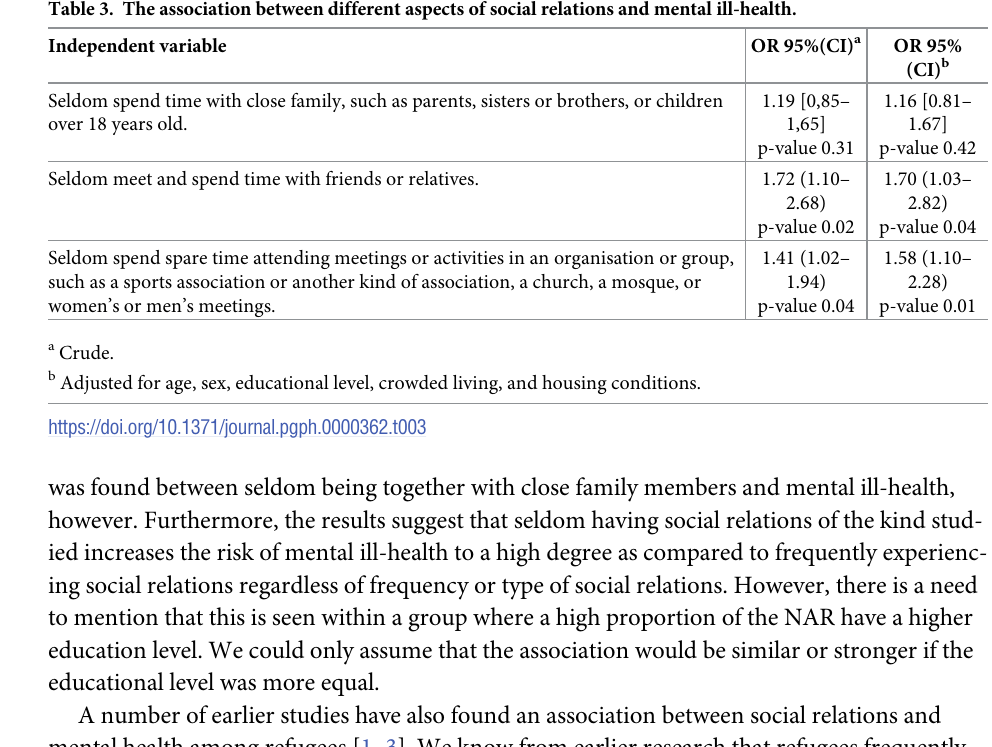
Table 3. The association between different aspects of social relations and mental ill-health. Independent variable OR 95%(CI) a OR 95% Seldom spend time with close family, such as parents, sisters or brothers, or children over 18 years old. Seldom meet and spend time with friends or relatives.